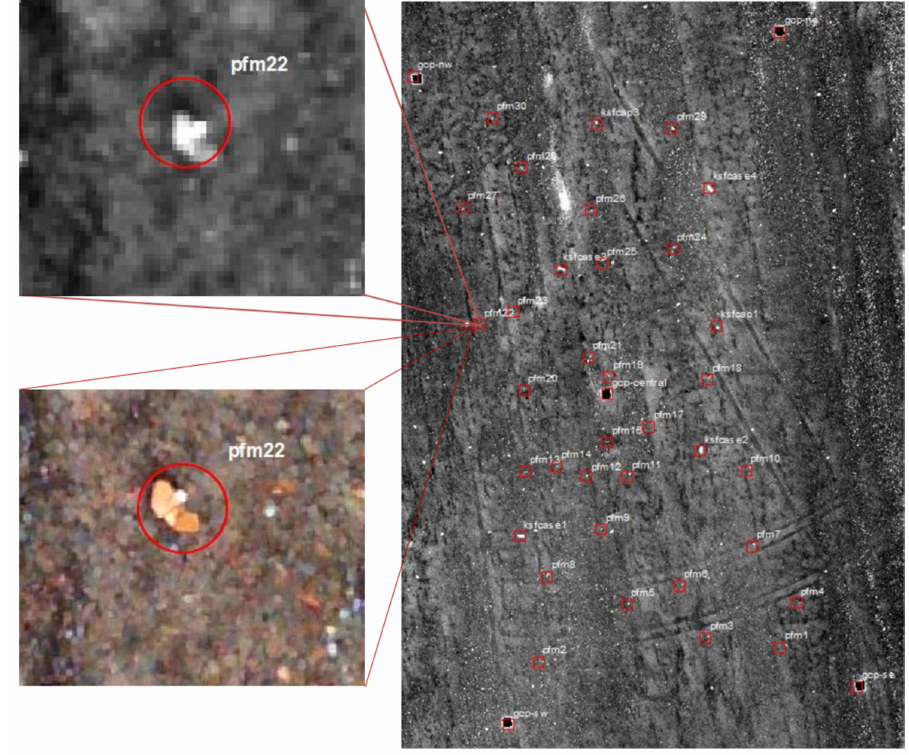
Figure 8. Georeferenced green bandwidth orthophoto (with RGB picture of PFM-1 landmine shown for comparison), overlaid with cm scale accurate shapefile taken from the Trimble Geo